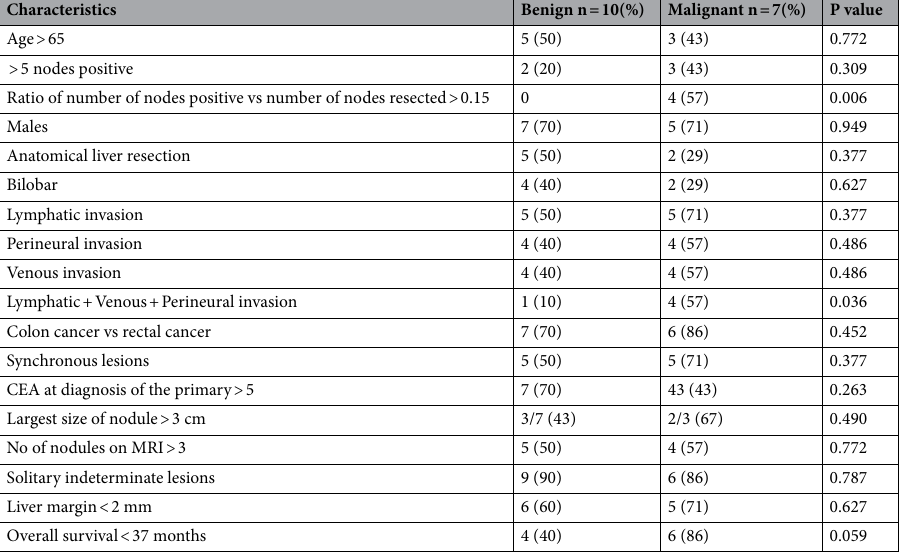
Table 2. Comparison of clinicopathological characteristics between patients with benign or malignant nodules in the follow up group. MRI magnetic resonance imaging, CEA carcinoembryonic